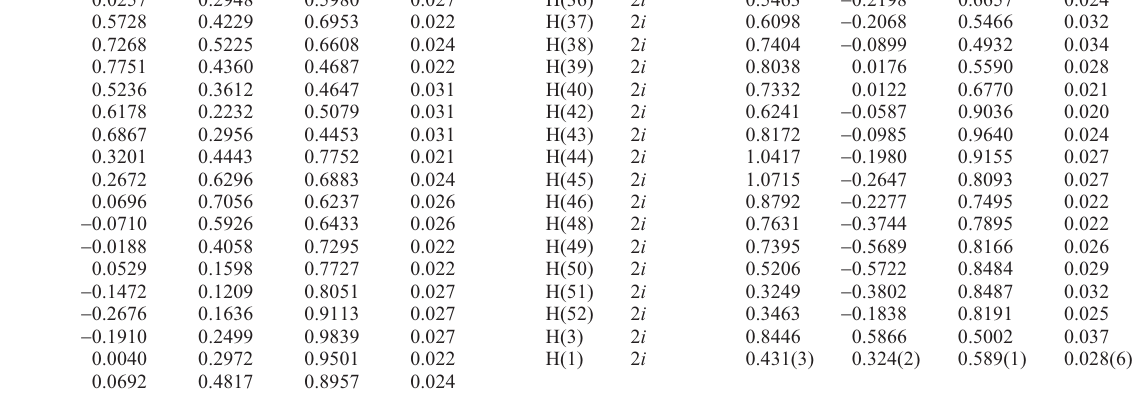
Table 3. Atomic coordinates and displacement parameters (in Å 2 ) .